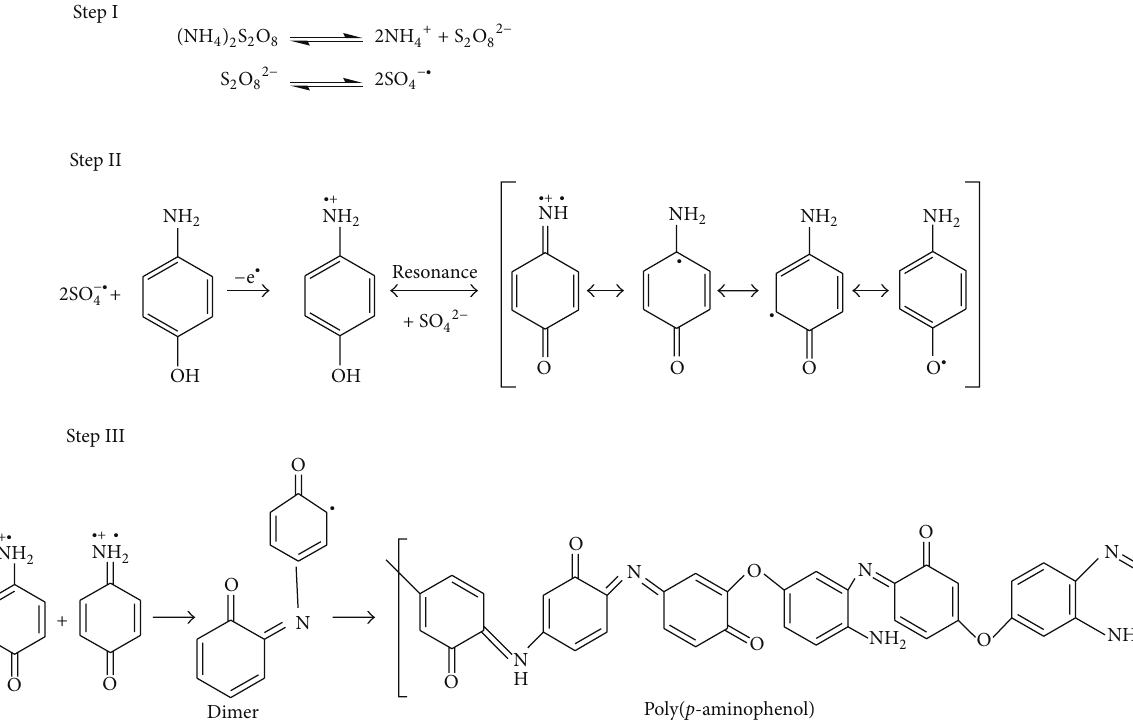
Scheme 3: Proposed mechanism of polymerization of p -aminophenol. Table 1: Elemental analysis and molecular weights of isomers of aminophenol. Elemental analysis Molecular Polymers